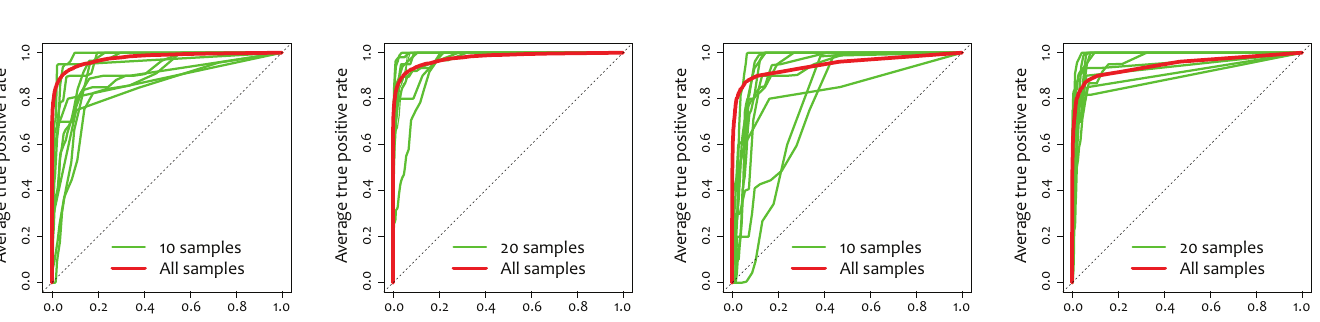
Fig 3. (A) ROC curves representingthe accuracyof predictiveallelicmapping.Among all pairs of ChIP-seq and RNA-seq variants connectedvia chromatin interaction, we collectedtrue cases (pairs showingalleleimbalancein both ChIP-seq and RNA-seq) and subjectedthem to RandomForest training. ROC curves were generatedbasedon 5-fold cross-validation with each validation process based on two RandomForest models. The red curves represent performance achievedwith the entire set of samples (100 samples for H3K27acand 59 for H3K4me1). The blue curves show performance with a subset of samples. The samplingwas repeated10 times to estimate variationin performance. (B) ROC curves indicating the accuracy of predictive QTL mapping.